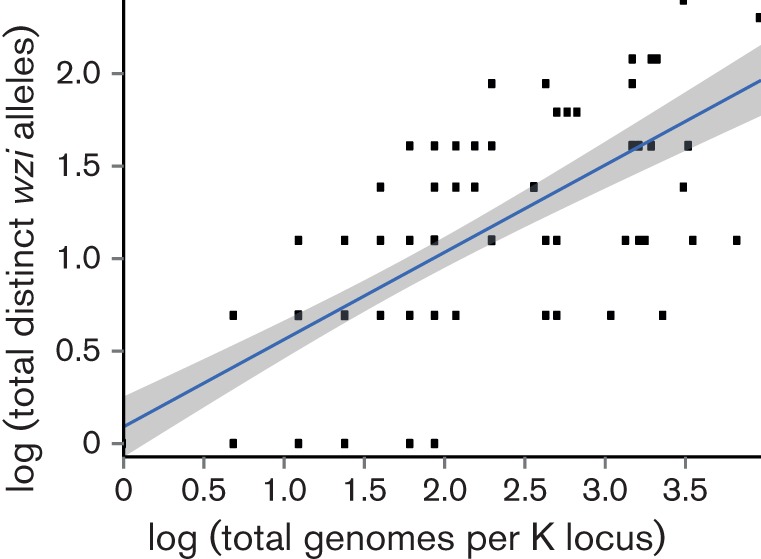
Allelic diversity of wzi. Within K-locus wzi allelic diversity increases with total K-locus representation. The blue line represents the least-squares regression and grey shading indicates the 95 % confidence interval.